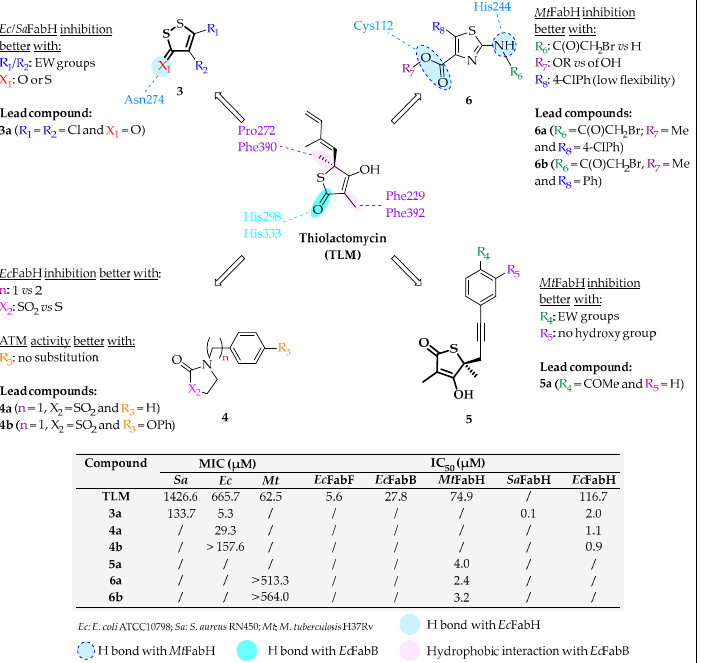
Figure 8. Structures, SAR and representation of main interactions with Ec FabB, Ec FabH and Mt FabH of TLM and its analogues 3–6 and in vitro activities of lead compounds